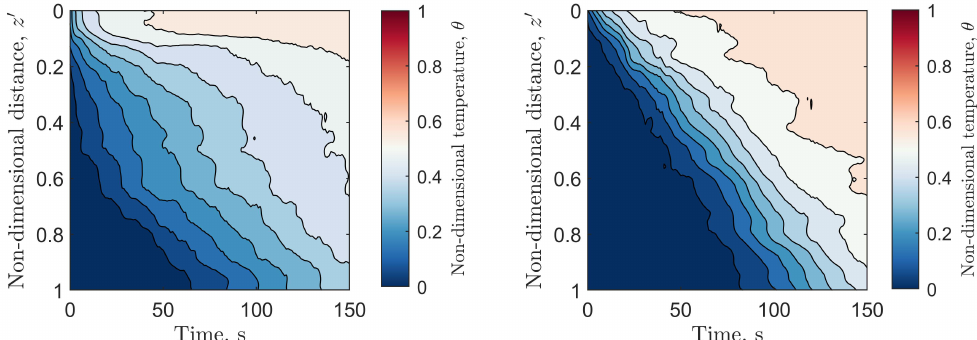
Figure 4. Thermal response of the test section without packing media ( left ) and with packing media ( right ). A steeper thermocline was achieved with the presence of packing media as the packed bed particles minimized advection in the axial direction.